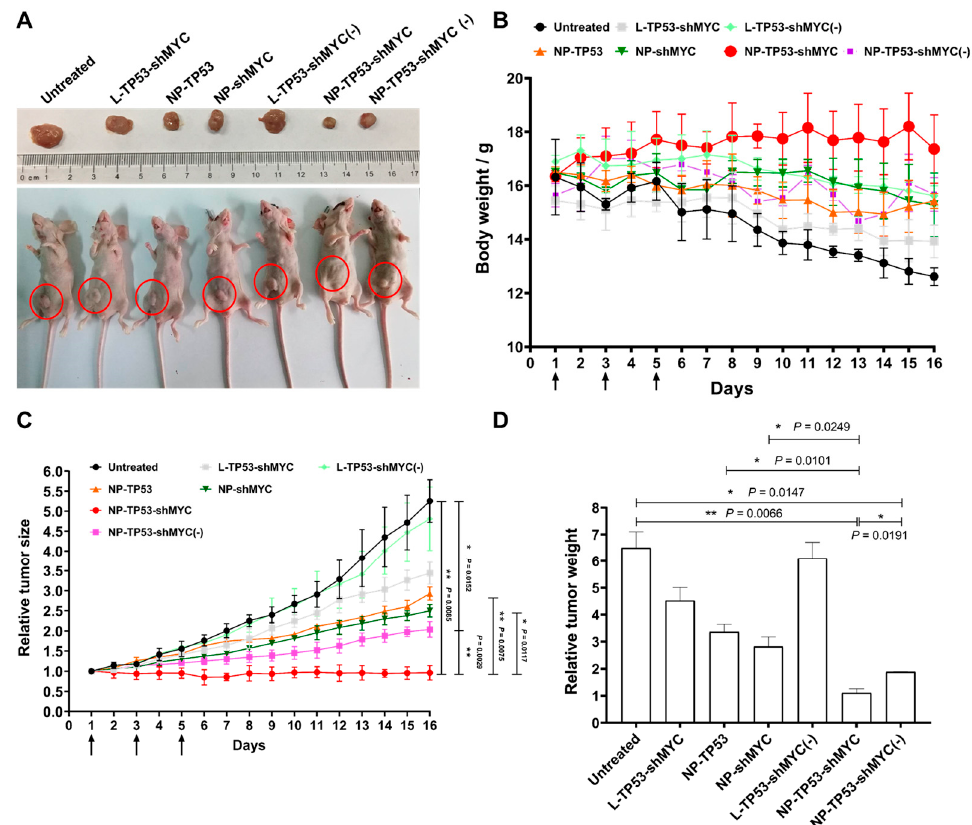
Figure 5. NP-TP53-shMYC inhibited in vivo tumor overgrowth through the simultaneous overex- pression of p53 proteins and the strong elimination of c-Myc proteins. ( A ) Photograph of excised tumors and treated mice on the 16th day post-administration. ( B ) The change in the body weight of MDA-MB-231-tumor-bearing mice was recorded within 16 days after treatment in different groups (black arrows indicate time points of each treatment). ( C ) The change in the relative tumor volume of mice was recorded within 16 days after treatment in different groups (black arrows indicate the time points of each treatment). ( D ) Relative tumor weight in different treatment groups on the 16th day post-administration. Untreated: saline treatment; L-TP53-shMYC: L-TP53-shMYC formulated